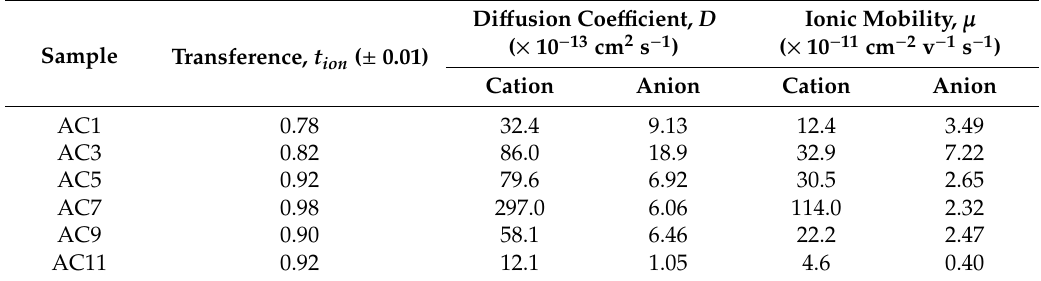
Table 5. The transference value and respective percentage of cation / anion of CMC-AC biopolymer films.